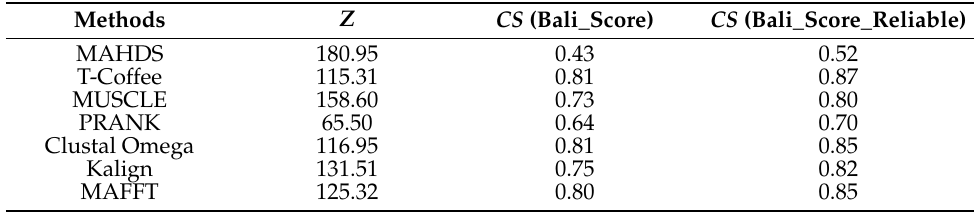
Table 2. Mean Z and CS values for BAliBASE protein families’ alignments produced by different